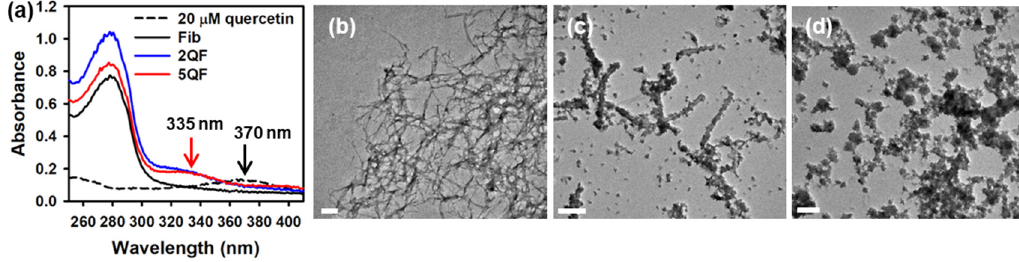
Figure 1. ( a ) UV-Vis absorption spectra of free quercetin, Fib, 2QF, and 5QF. TEM images of ( b ) Fib, ( c ) 2QF, and ( d ) 5QF. The scale bar in TEM images represents 200 nm.